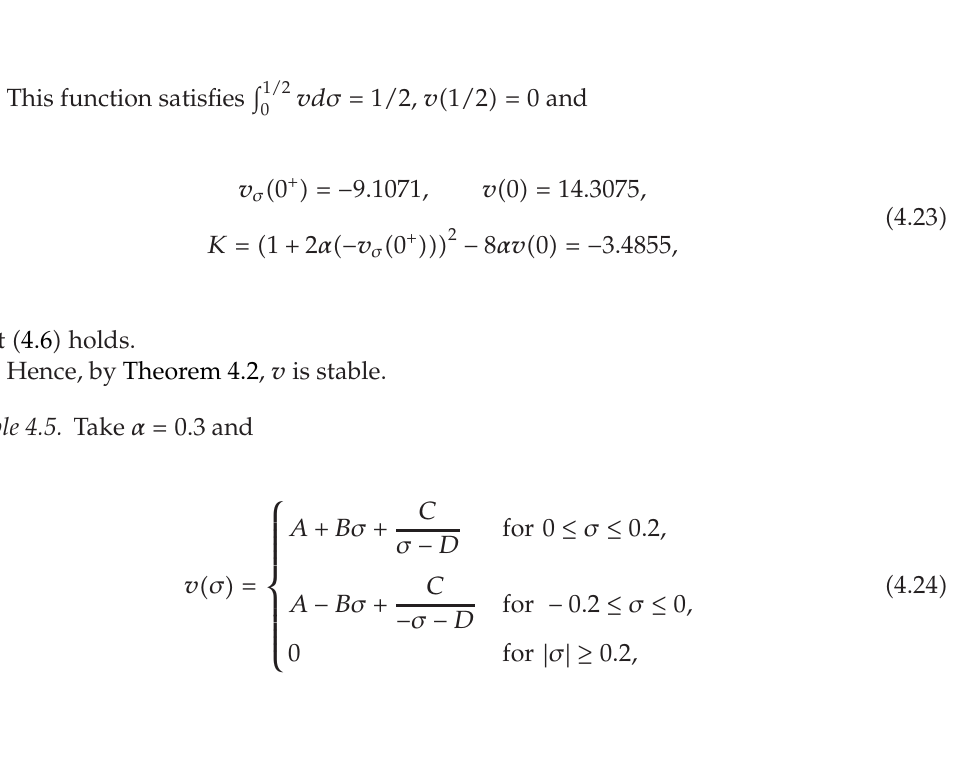
Figure 12: Graphics sequence: Example